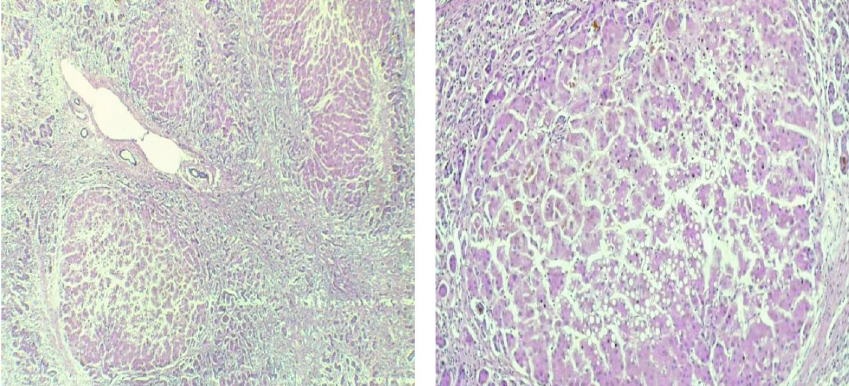
Figure 1: Microscopic examination shows liver tissue with di ff use nodular architecture, regenerative changes, marked ductular proliferation, and mild macrovesicular steatosis involves about 10 percent of liver tissue and scattered bile plugs (deposition of copper was not seen in our specimen).